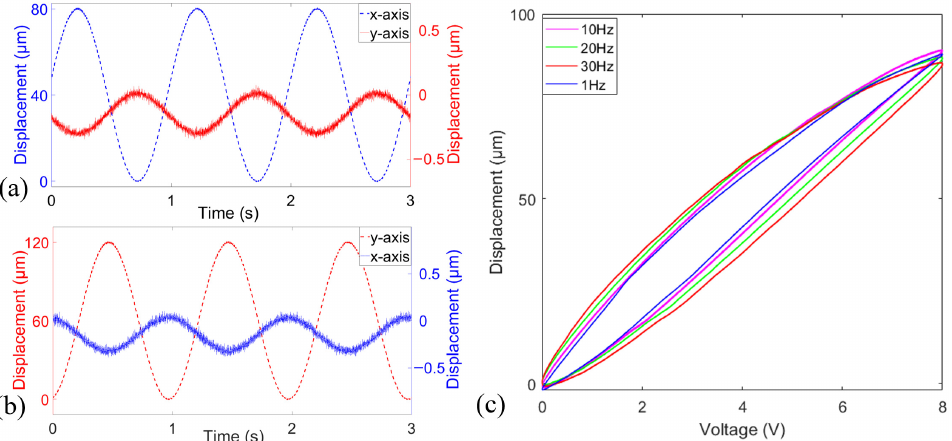
Figure 10. Open-loop test. ( a ) Driving along the x -axis. ( b ) Driving along the y -axis. ( c ) The hysteresis effect of the piezoelectric